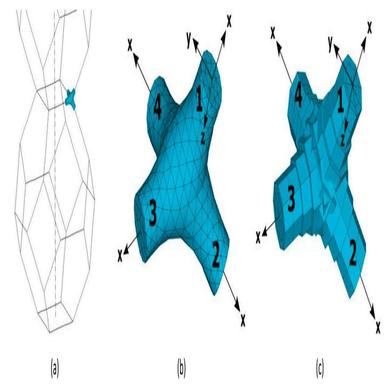
(a) A connection node between two cells composed of four ligaments, (b) a connection node meshed realized with solid elements, (c) a connection node realized with beam elements.